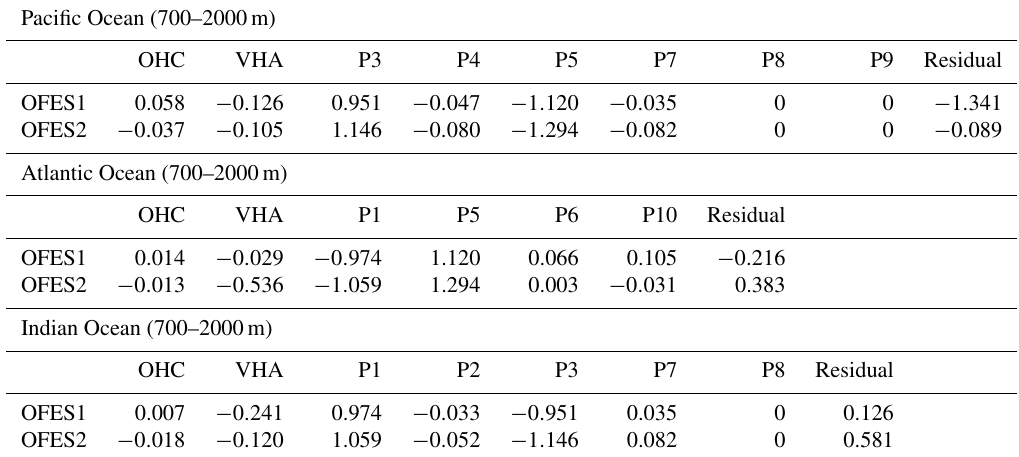
Table 4. As for Table 2 but for the lower layer (700–2000m). VHA is at a depth of 2000m. Pacific Ocean